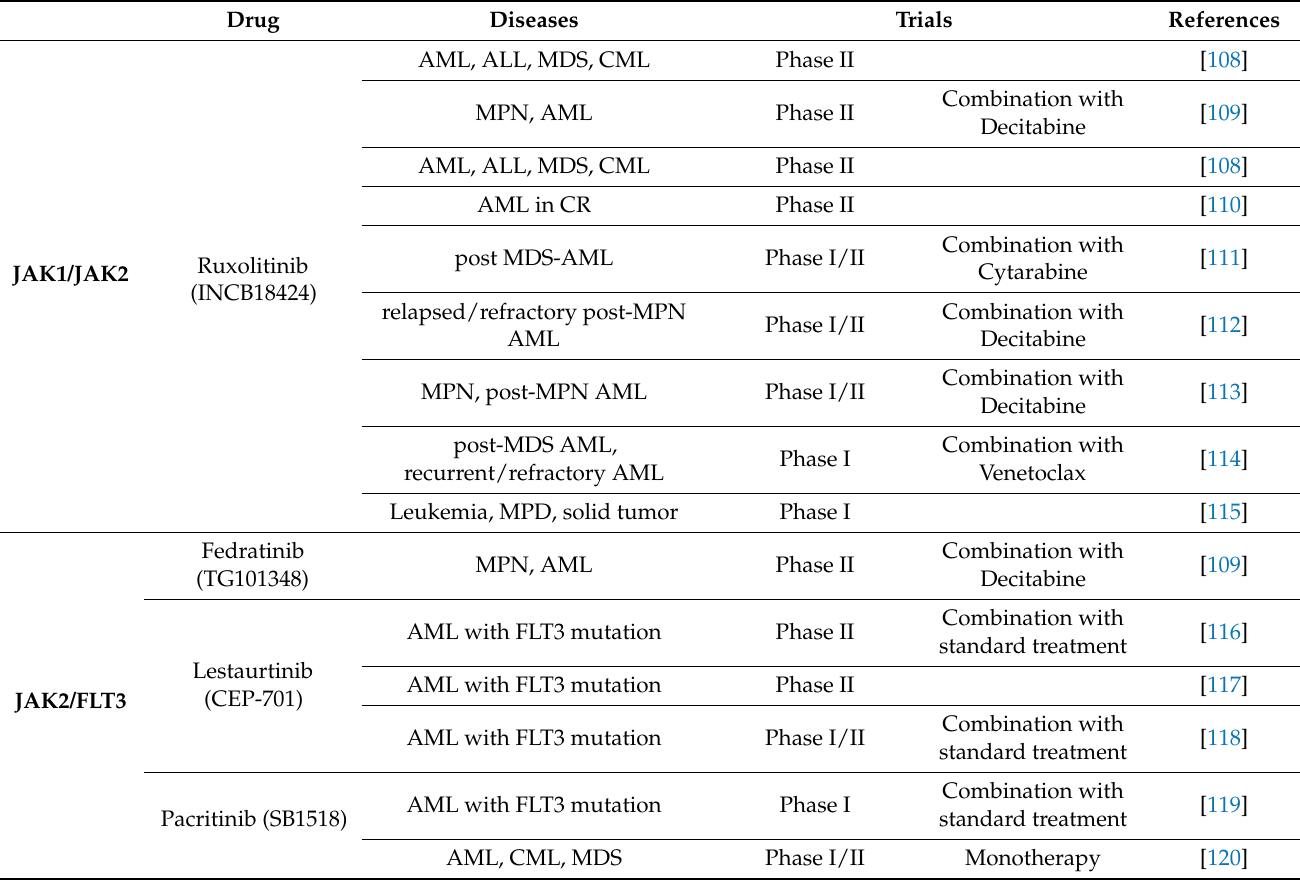
Table 1. Current clinical trials of JAK inhibitors in